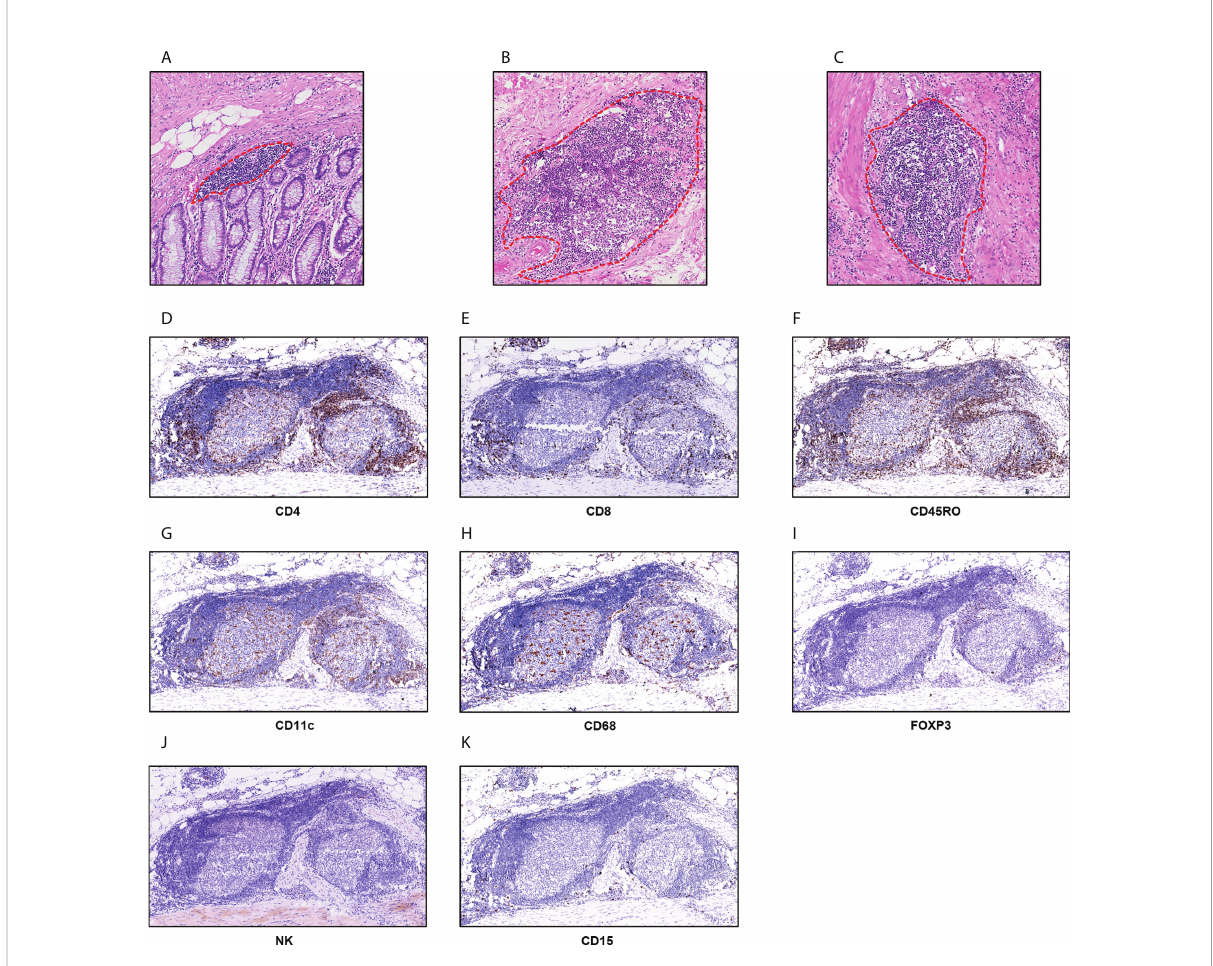
FIGURE 2 TLS in nmCRC. (A) The mucosal TLSs were almost squished and elongated or teardrop-shaped; (B, C) the submucosal and basal lamina propria TLSs were usually oval-shape; (D) CD4+ T cells; (E) CD8+ T cells; (F) CD45RO+ lymphocytes; (G) CD11c+DC cells; (H) CD68+ TAMs; (I) FOXP3 + Tregs; (J) NCR1+ NK cells; (K) CD15+